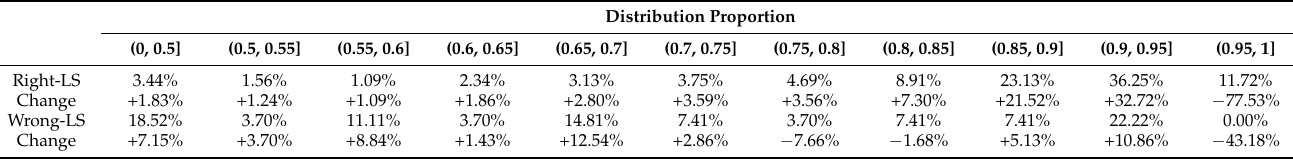
Table 5. p ’s distribution of samples detected by RGBI model. “Right” represents correctly detected samples, “Wrong” represents incorrectly detected samples. “LS” represents the sample detected by RGBI model with label smoothing, and “Change” refers to the proportion change of p in the distribution interval after label